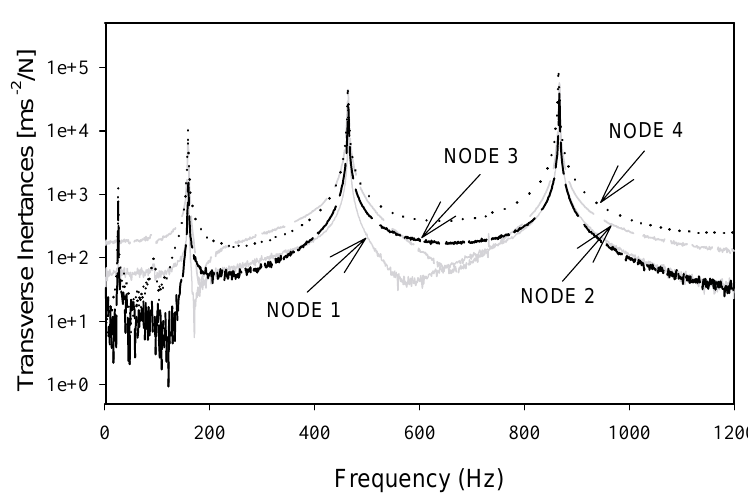
Fig. 7. Measured transverse inertance FRF at nodes 1–4 of the cantilevered beam structure with a bolt-joint.